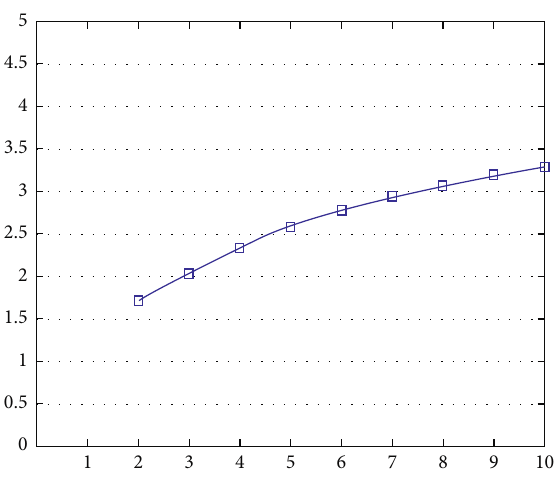
Figure 4: Randic entropy of HDN1 ( n ) for α � 1.